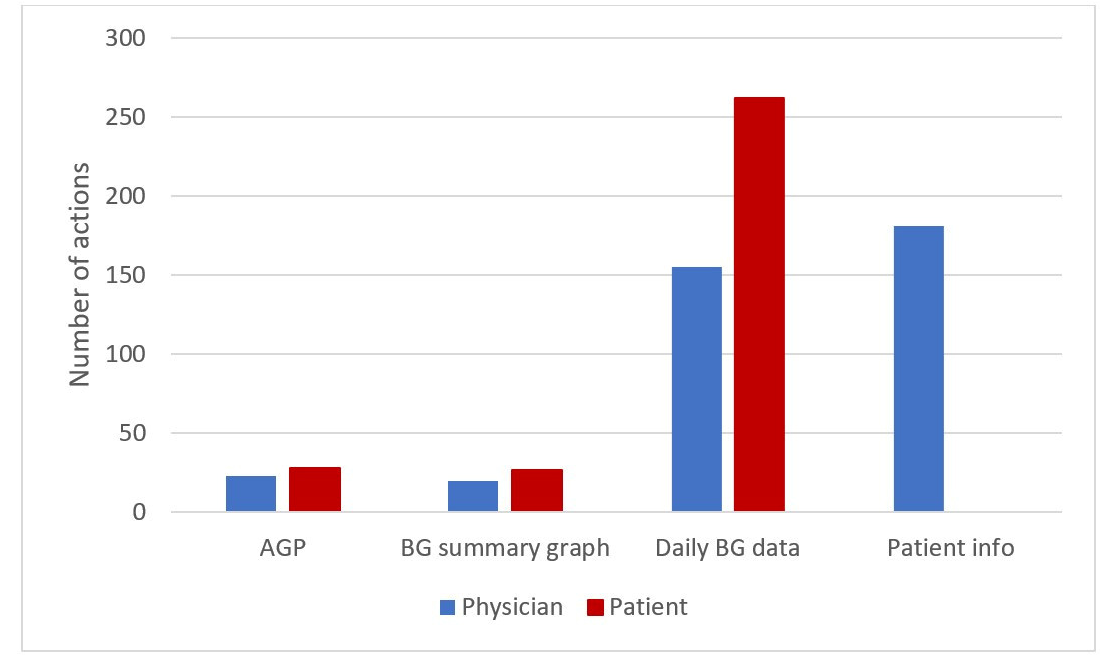
Figure 15. Distribution of the visualization Figure 15 . Distribution of the visualization action.